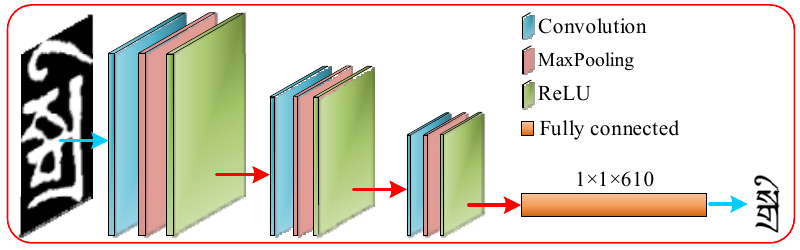
Figure 5. Character recognition model framework.